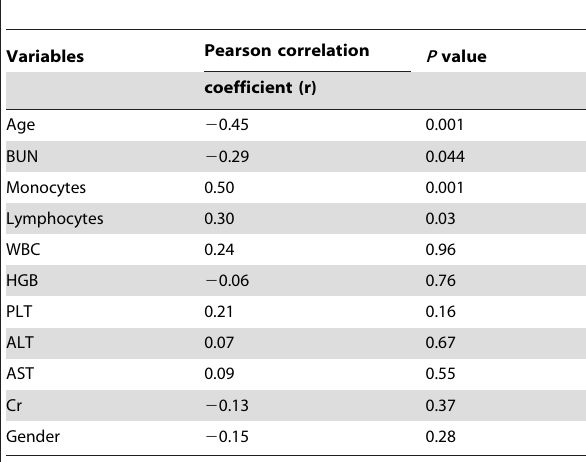
Table 3. Multivariate regression analysis of variables associated with s-TRAIL in septic patients.